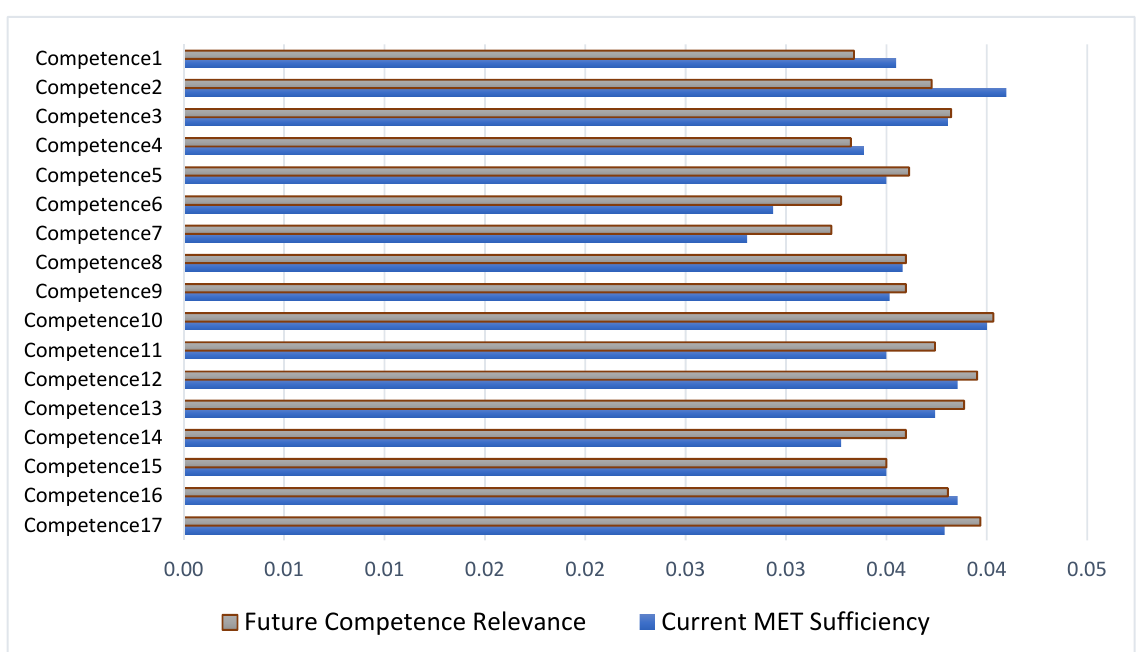
the corresponding competencies (i.e., the competencies 1, 2, 4, and 16). In contrast, nega- tive difference with higher mean score for “future relevance” indicate that the correspond- ing competencies (i.e., the competencies 3, 5, 6, 7, 8, 9, 10, 11, 12, 13, 14, and 17) are per- ceived to be highly relevant in the future to efficiently operate degree-2 autonomous ships (see Figure 1).